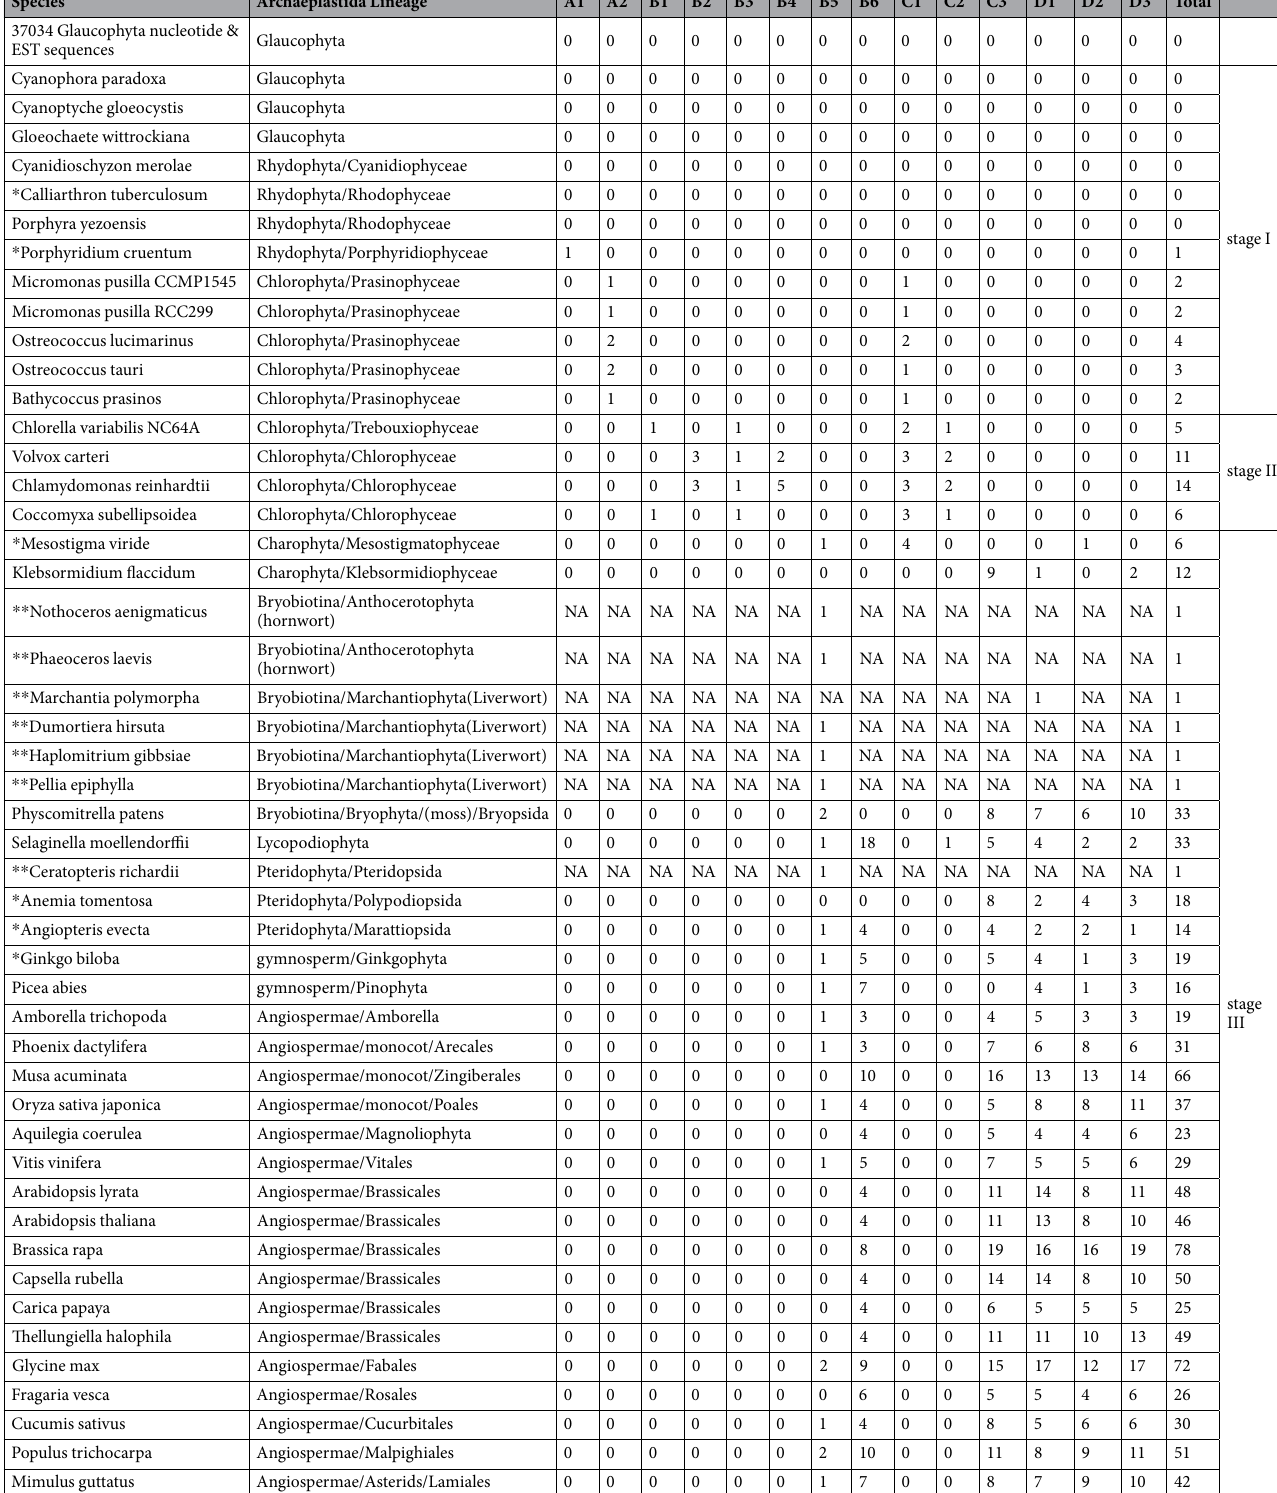
Table 1. Numbers of CFKs in different species and subfamilies. “NA” stands for unknown number due to lacking of the genomes/transcriptomes. * Indicates partial genome or RNA-seq sequences available. ** Indicates only limited sequences and without transcriptome sequences nor